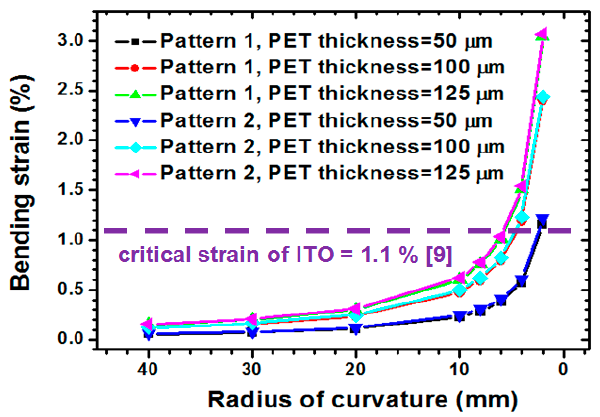
Figure 10. Pattern and PET thickness effects on the variation of ITO bending strain induced by different bending radiuses.